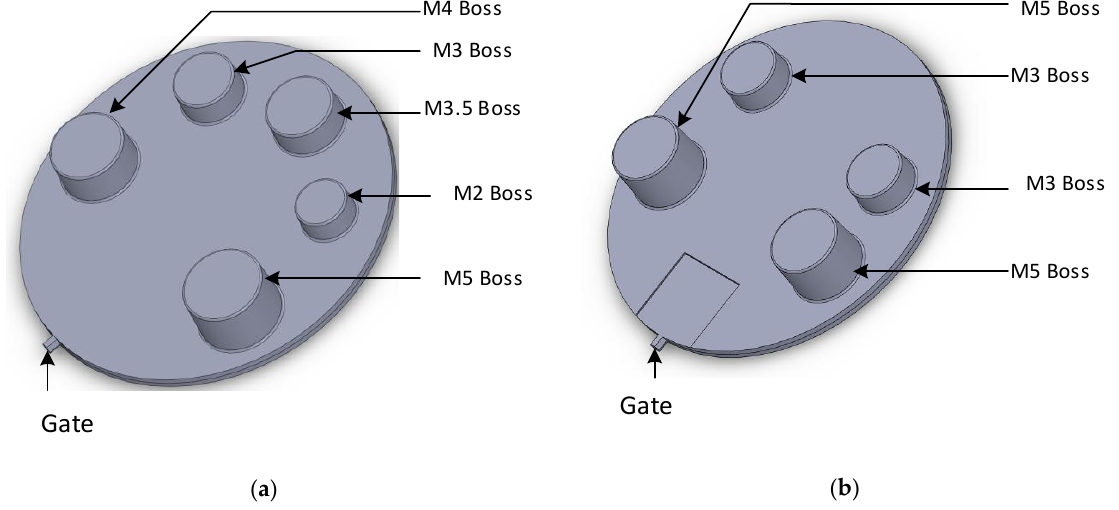
Figure 4. ( a ) Original part design showing 5 bosses and pin layout; ( b ) redesigned part showing 4 bosses and modified pin layout.